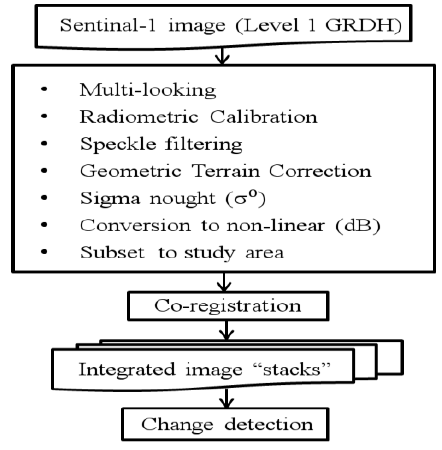
Figure 2. Flowchart of Sentinel-1 SAR data